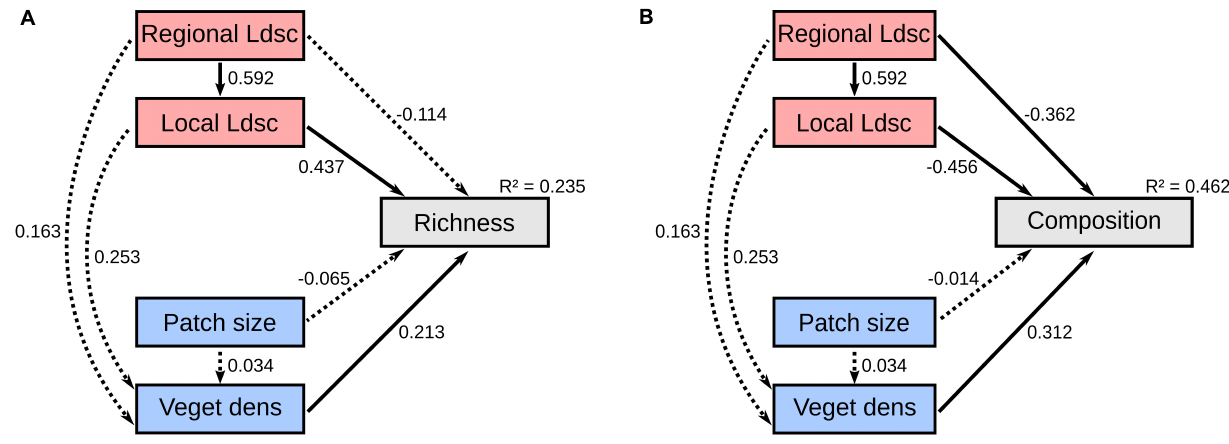
FIGURE 2 | Structural equation models examining the direct and indirect effects of landscape-level (red) and patch-level (blue) variables on small mammal diversity of a woodland savanna region of South America. (A) Extrapolated species richness and (B) species composition (PCoA axis 1). Species richness was extrapolated for each site using the Chao index. Significant paths ( p < 0.05 ) are shown in solid black arrows and non-significant paths are shown in dashed arrows. The values underlying the lines indicate standardized path coefficients. extrapolated species richness (Richness), species composition (Composition), regional landscape cover (Regional Ldsc), local landscape cover (Local Ldsc), and vegetation density (Veget dens).